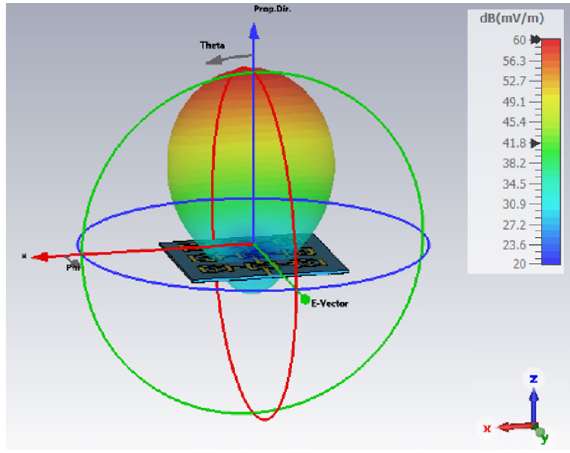
Figure 9. Simulated radiation pattern of the single antenna array.